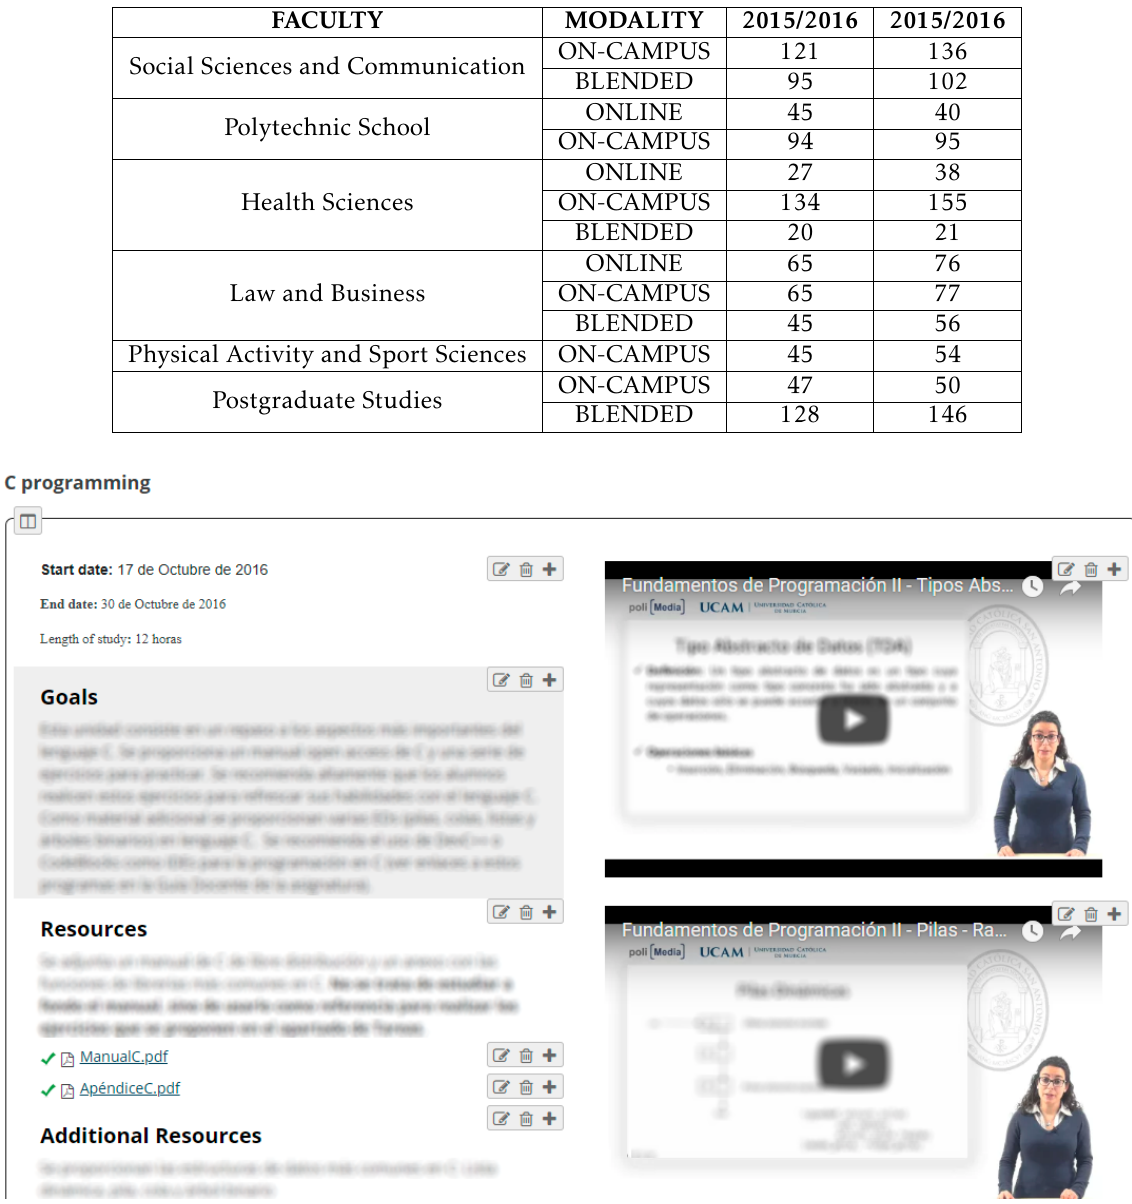
Figure 1. A screenshot of the Lesson Builder tool in Sakai showing a typical organization for a learning unit including goals, resources and videos. Text and images are intentionally blurred for the sake of